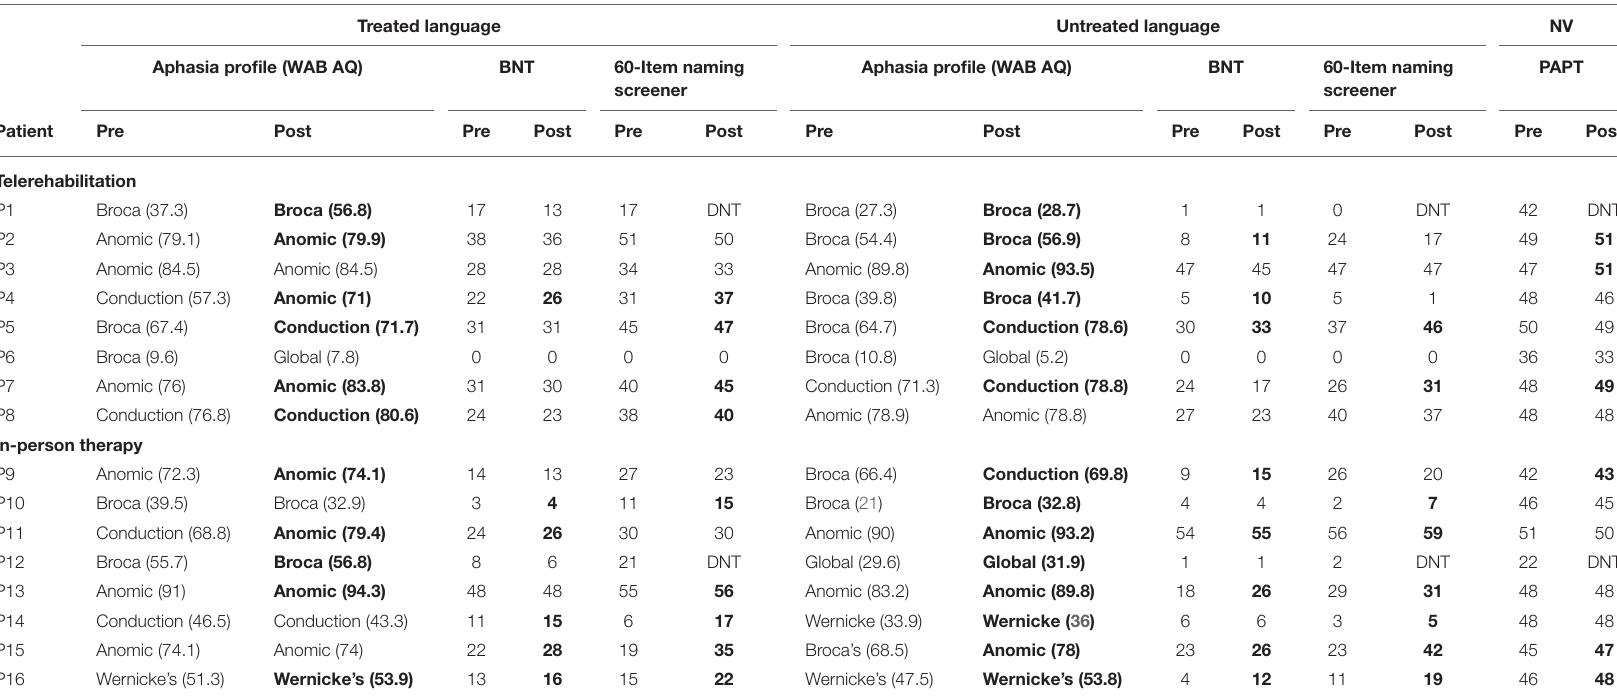
TABLE 3 | Profile of pre and post treatment scores on secondary treatment outcome measures in the treated and the untreated language in the bilingual adults with aphasia. Treated